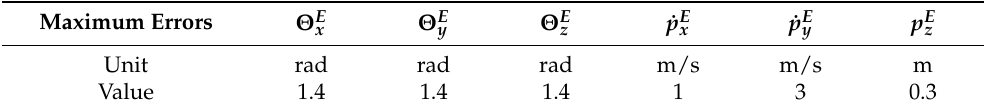
Table 3. The maximum errors of the training.